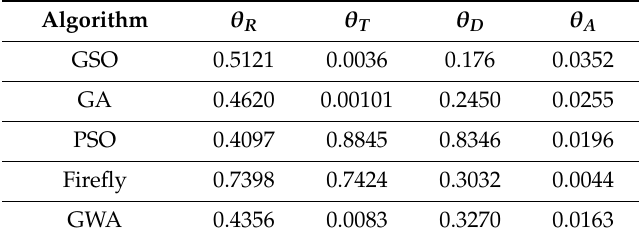
Table 12. Example 2: Tuning parameters with an optimization tool.